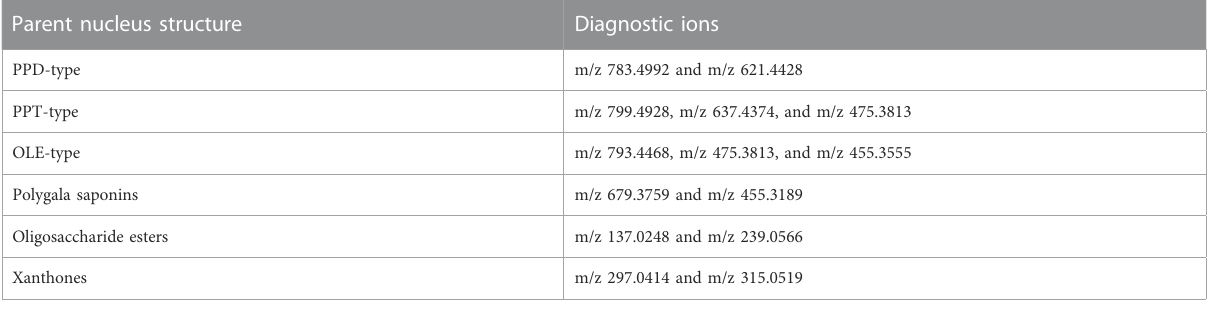
TABLE 1 Diagnostic ions for common compounds of the “ ginseng – polygala ” drug pair.